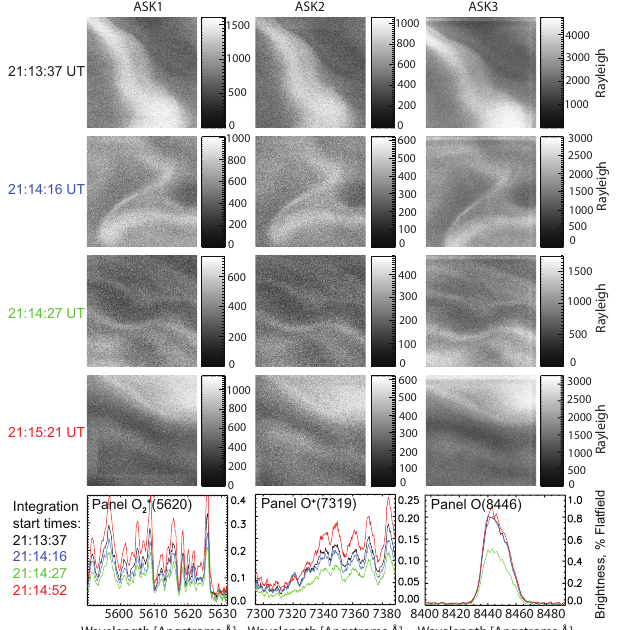
Fig. 4. ASK images for event 2, 2 January 2006, 21:00 UT. Rapid changes of the auroral forms are characteristic for this event, and the aurora is almost identical in all three ASK cameras. The bottom row of panels shows the SIF line spectra at the times of the ASK images. The scale of the line spectra is the same as in Fig. 2.